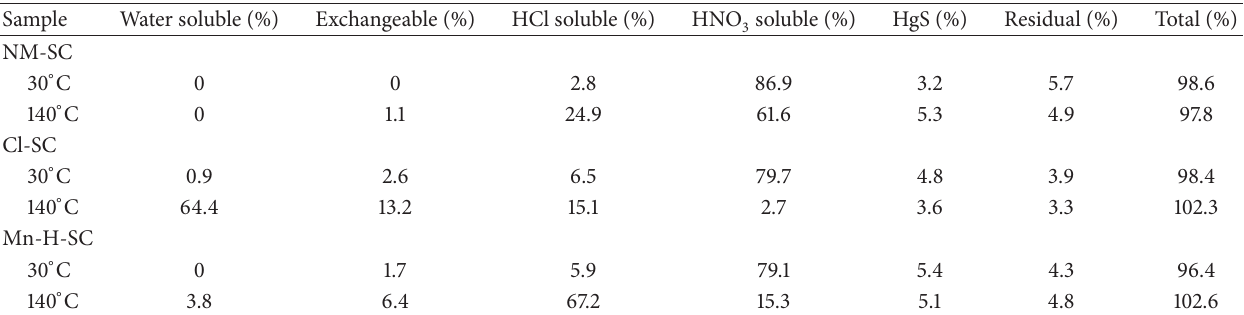
Table 5: Sequential extraction procedure results of semicoke adsorption